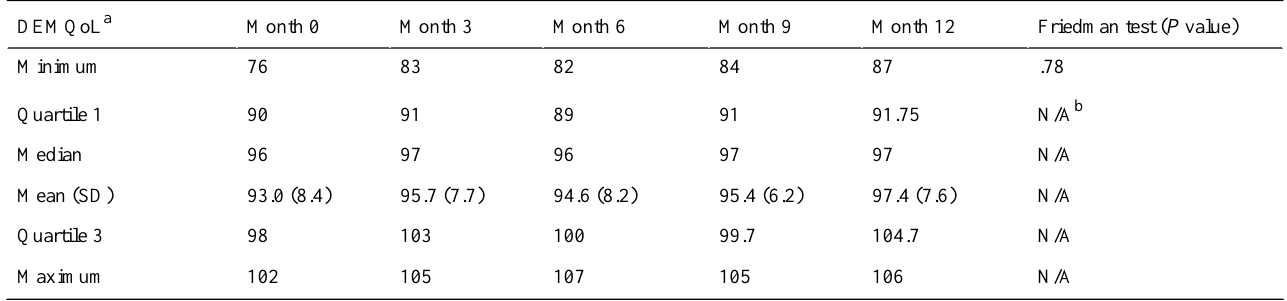
Table 9. Dementia Quality of Life score during the year follow-up.